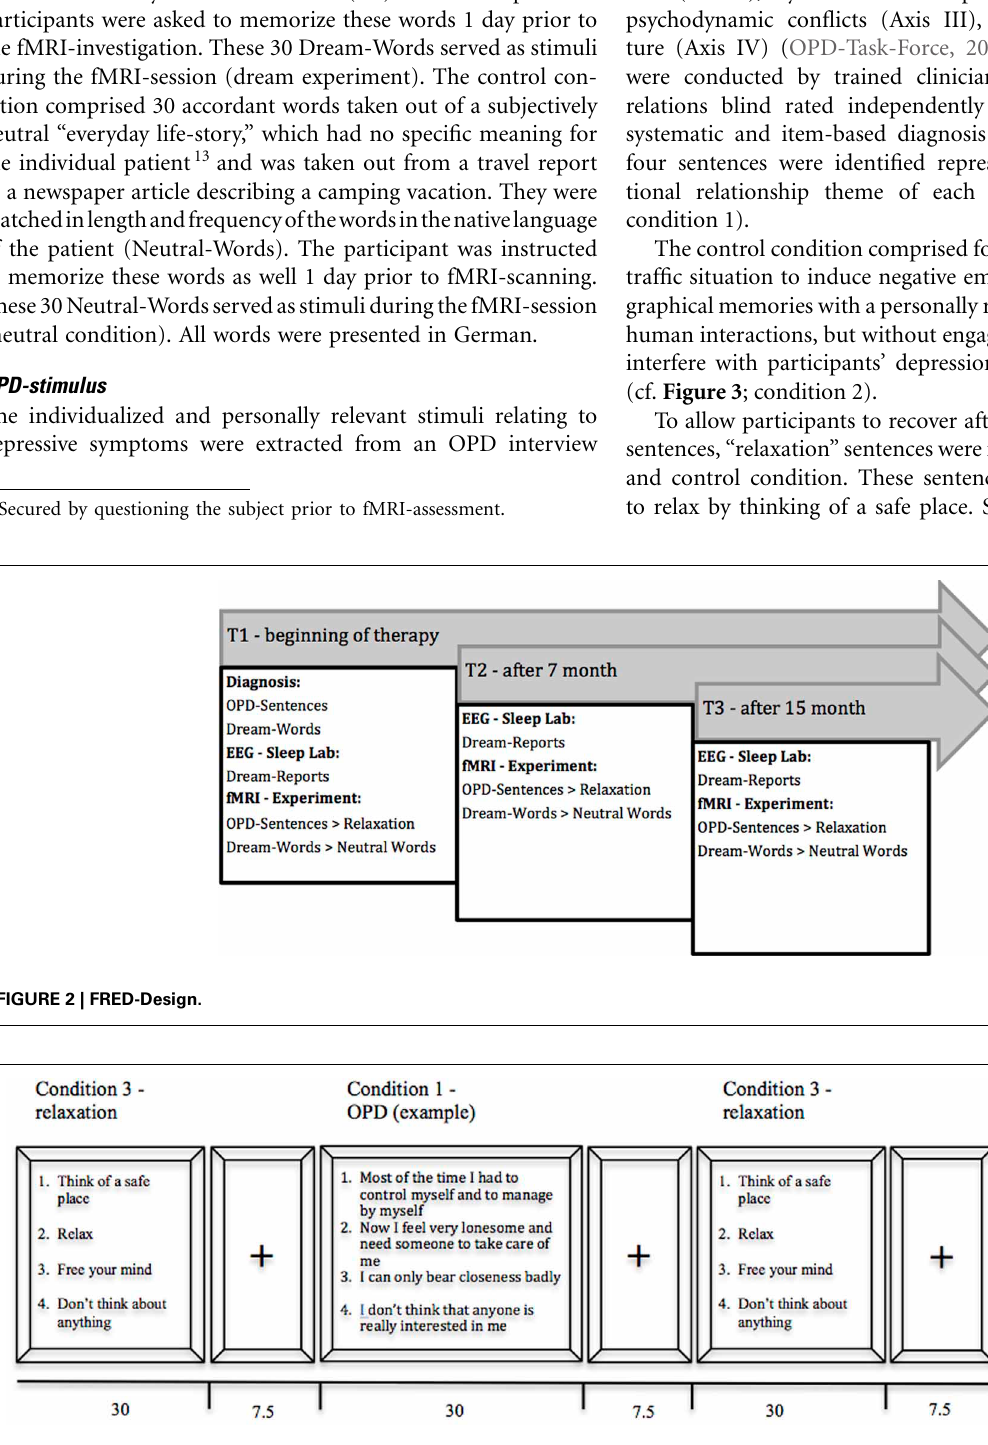
Frontiers in Human